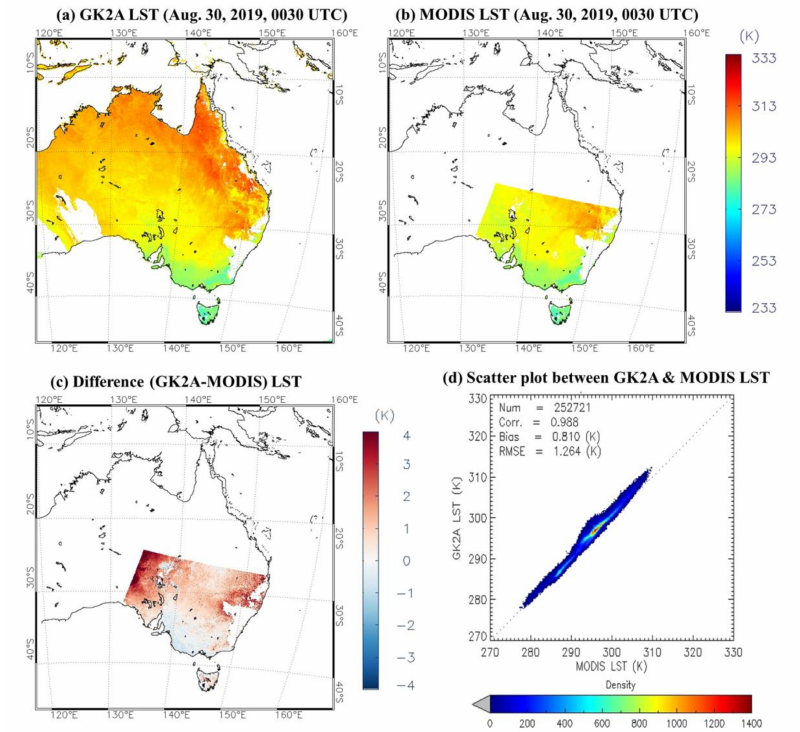
Figure 8. Spatial distribution of ( a ) GK2A LST, ( b ) MODIS (MOD11_L2) LST, ( c ) di ff erences between the GK2A and MODIS LSTs, and ( d ) scatter plot between the GK2A and MODIS (MOD11_L2) LSTs for 30 August 2019, 0030 UTC (gray dotted line in ( d ) represents the 1:1